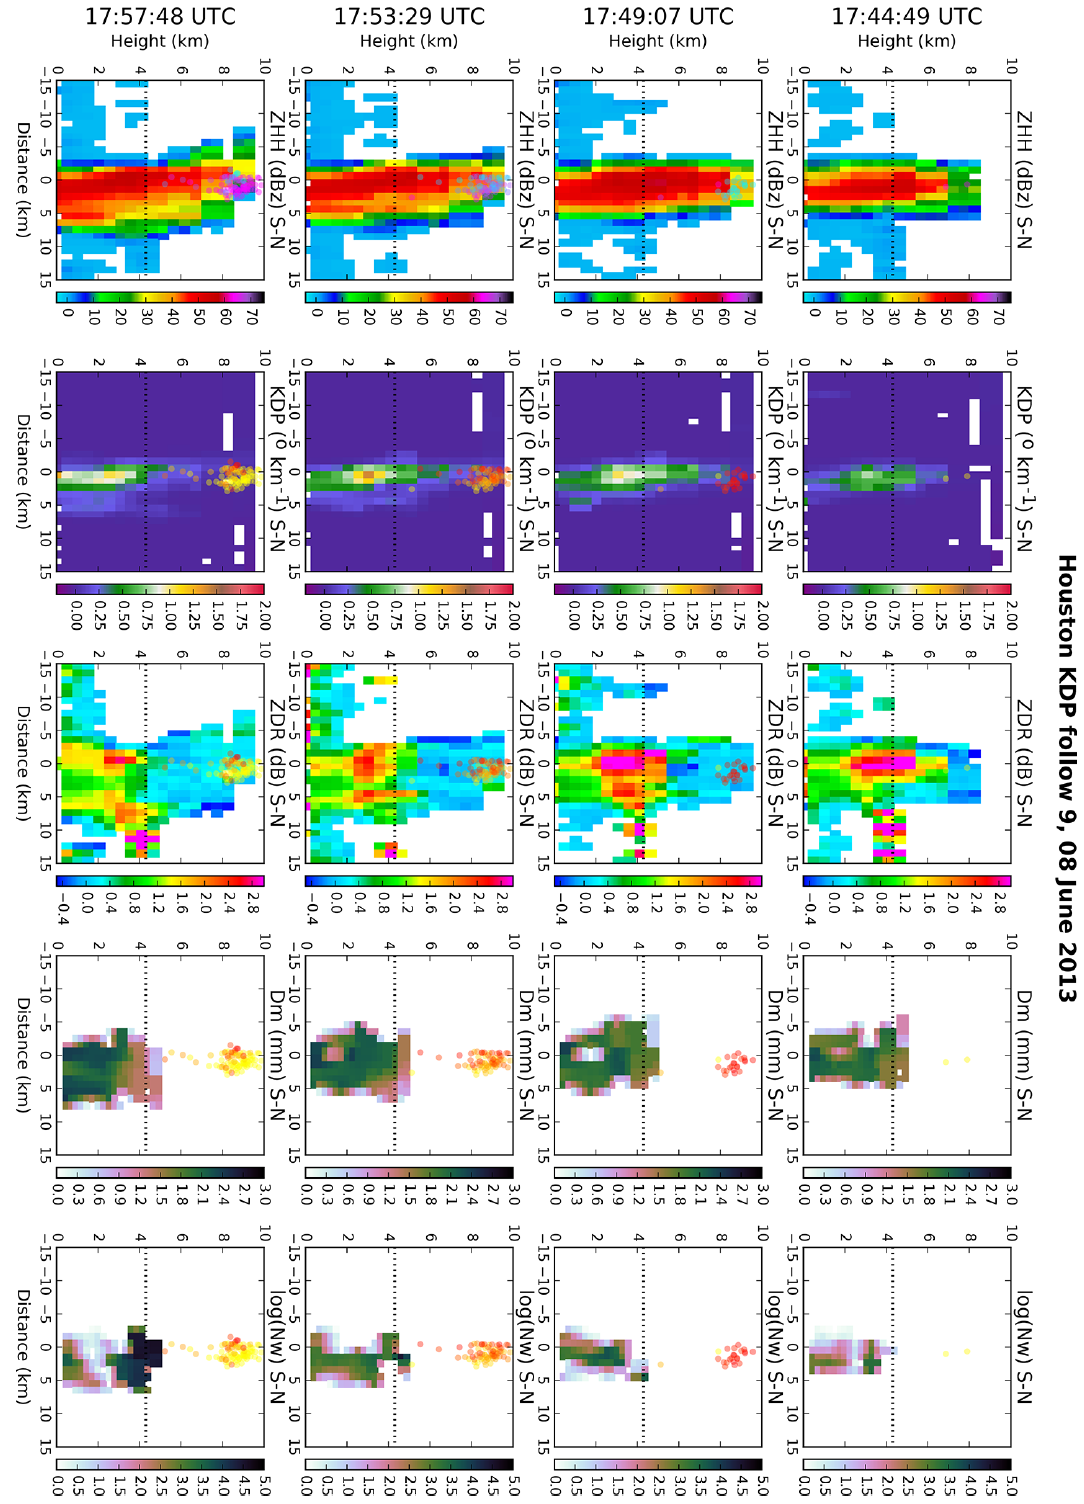
Figure 5. Sequential south–north cross sections from observed K DP column 9 show (left to right) Z HH , K DP , Z DR , D m , and N w . In all panels, the approximate melting level is indicated with a dotted line and each identified lightning flash is overplotted with a dot color indicating time sequence (yellow to red). Full time series shown in Fig.